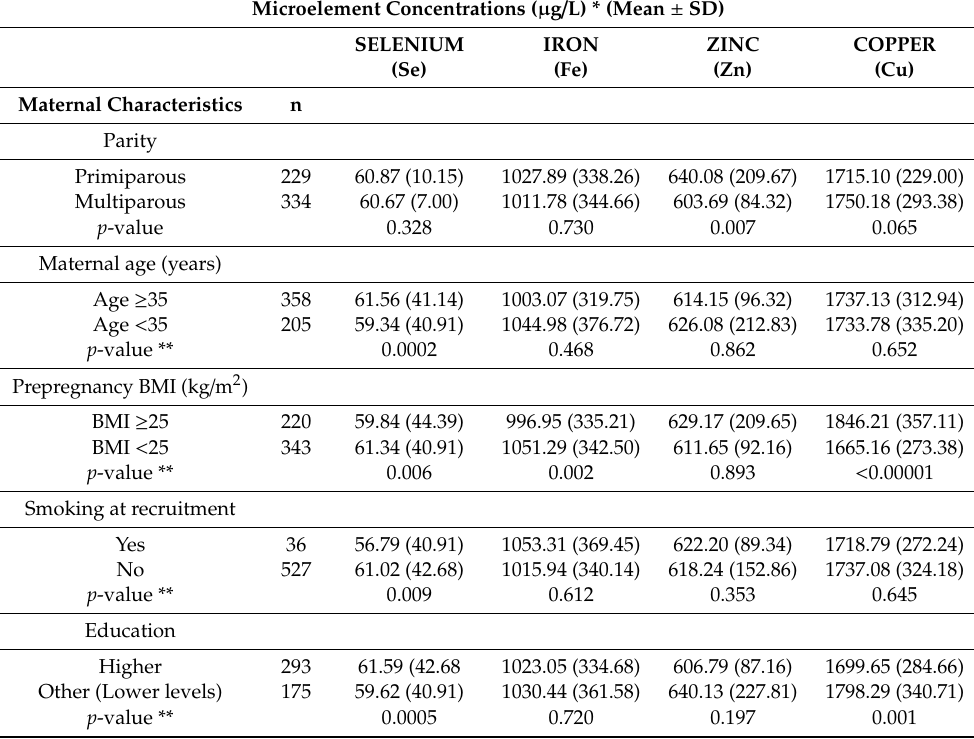
Table 2. Maternal characteristics and microelement concentrations (in serum from the 10–14th week of